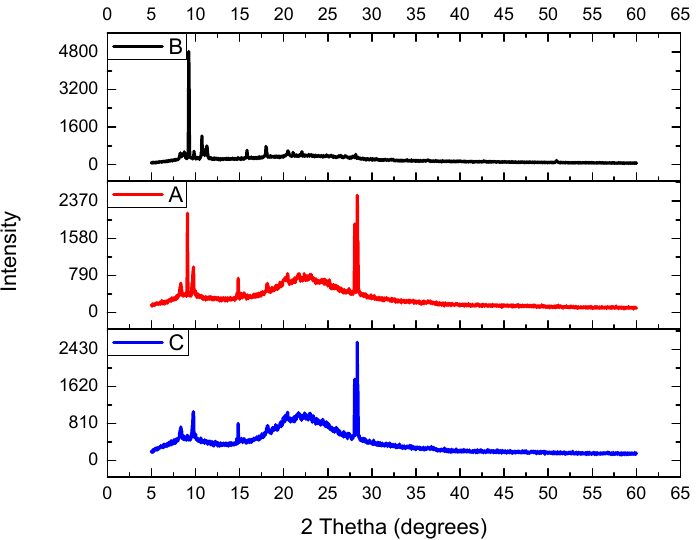
Figure 3. The PXRD of ( A ) the immobilized sulfuric acid on silica gel, ( B ) silica gel without catalyst, and ( C ) recovered catalyst after five cycles.